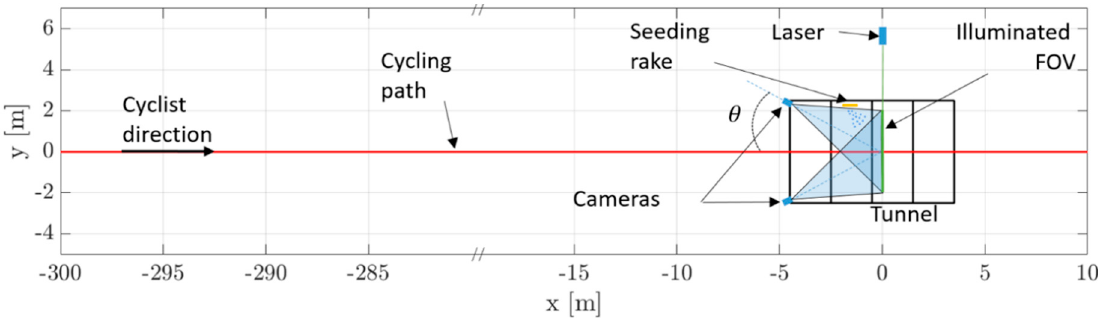
Figure 2. Detailed top view of the experimental setup.